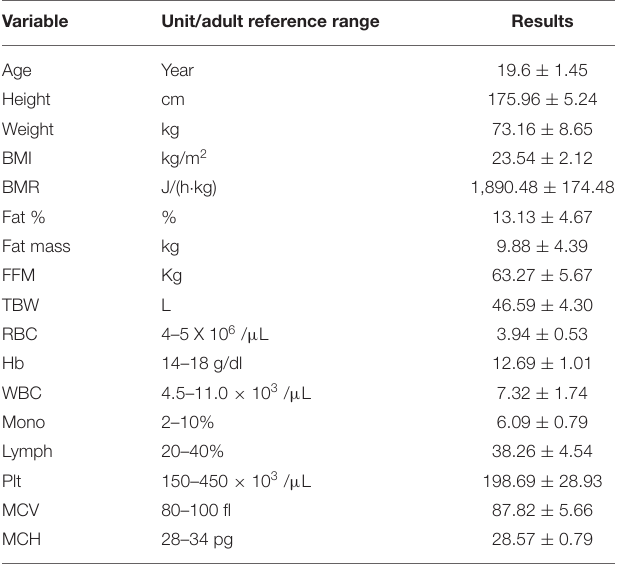
TABLE 2 | Baseline characteristics, anthropometric measurements, and placebo biochemical parameters.